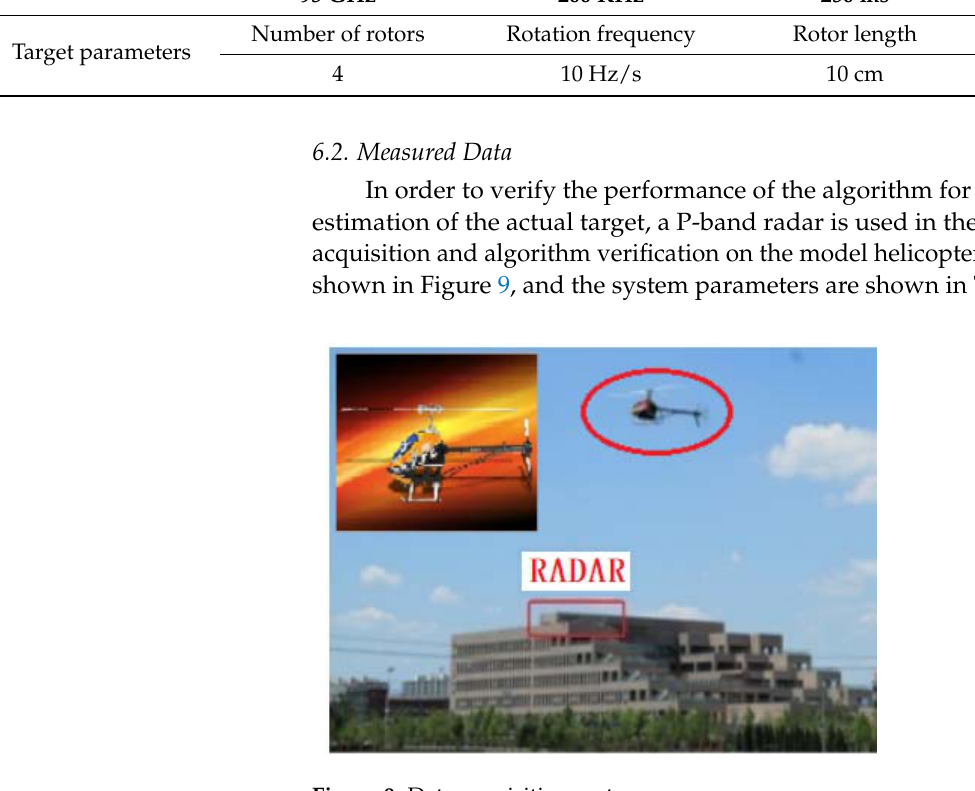
Table 4. Radar and Target Parameters.